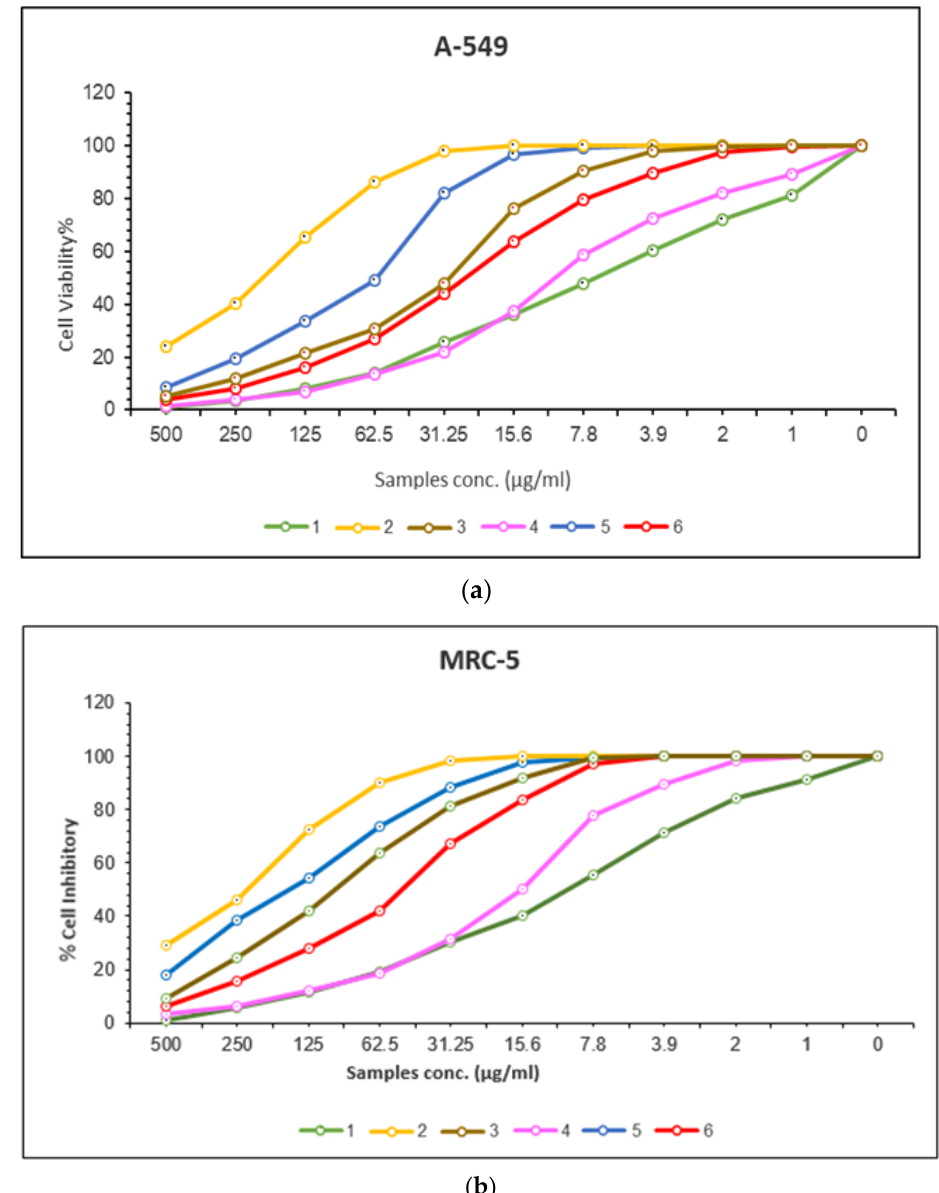
Figure 10. (a) A-549. The dose-response curves of the cytotoxicity of compounds ( 1 – 6 ). Cells were exposed to different concentrations of the compounds for 72 h. Cell viability was determined by a colorimetric method. (b) MRC-5cell lines. The dose-response curves of the cytotoxicity of compounds ( 1 – 6 ) Cells were exposed to different concentrations of the compounds for 72 h. Cell viability was determined by a colorimetric method. Table 5. The inhibitory effects (IC50%) (CC50%) of cisplatin compound and Mn(II), Co(II), Cu(II), Cr(III), and Pd(II) complexes against different types of cell lines.